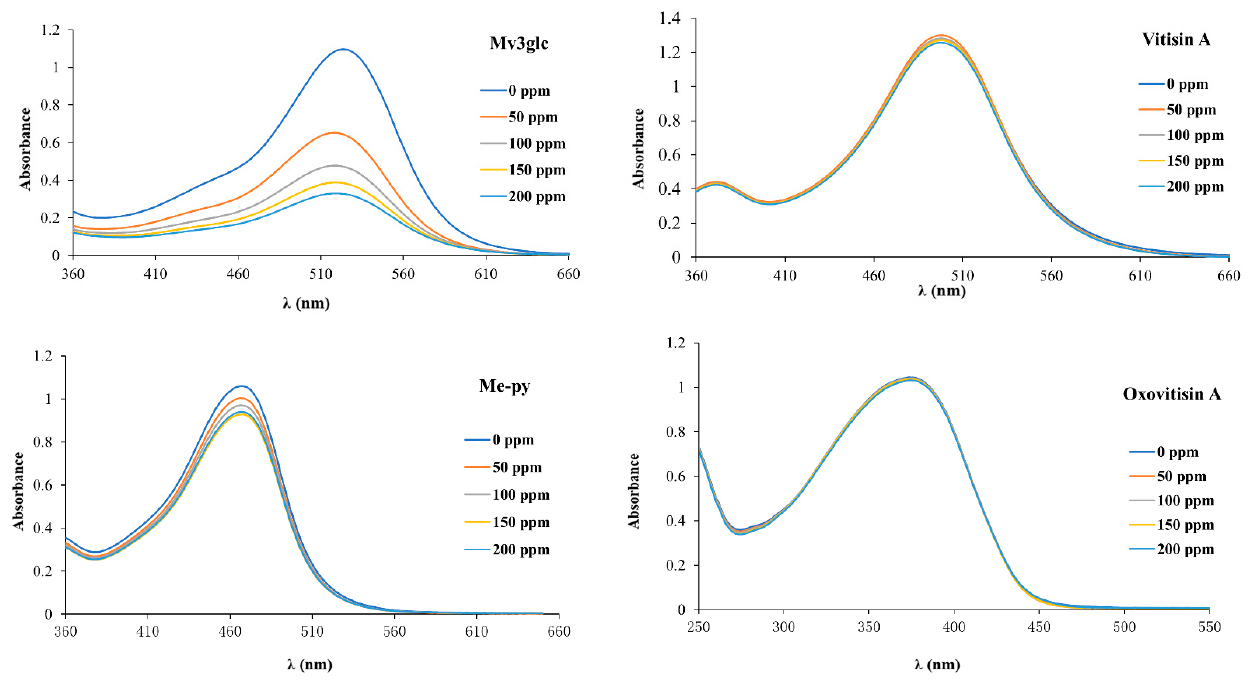
Figure 4. Visible spectral of Mv3glc, vitisin A, Me-py, and oxovitisin A under different concentrations of bisulfite.